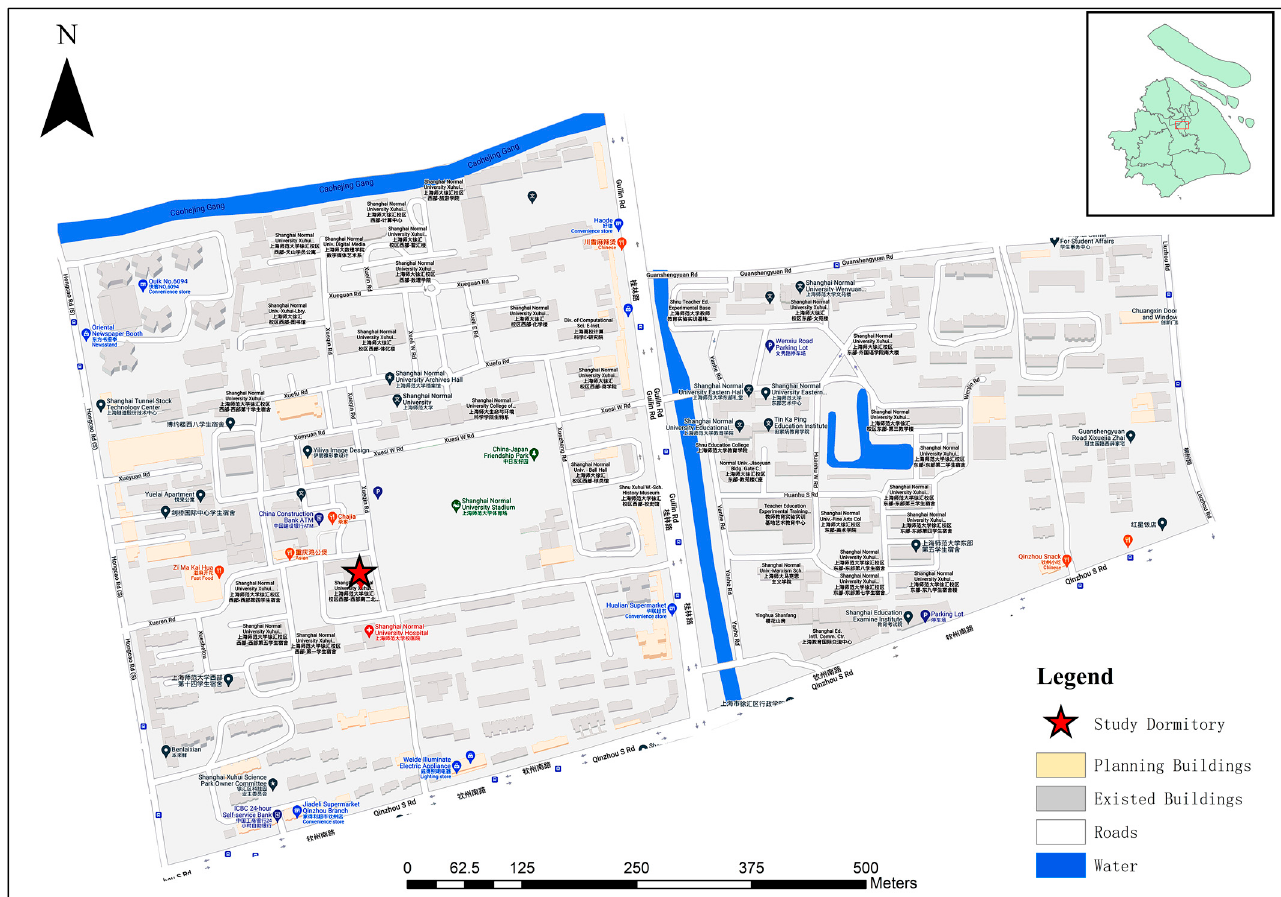
Figure 3. Study Dormitory in the Map of Shanghai Normal University.